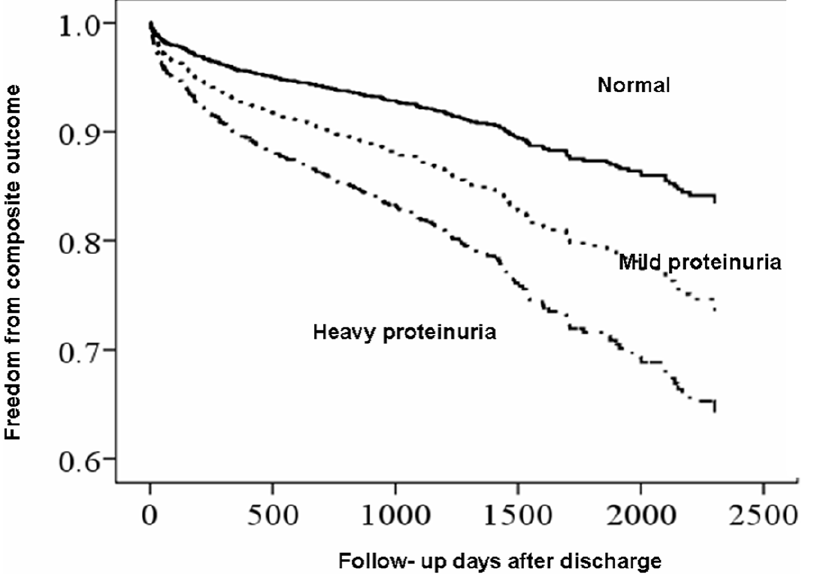
Figure 3. Proportion of freedom from long- term composite outcome after hospital discharge, composite outcome of ESRD and mortality, stratified by different severities of proteinuria defined by preoperative dipstick. (Mild proteinuria, p , 0.001; Heavy proteinuria, p , 0.001; No proteinuria was the reference calculated by multivariable Cox proportional hazard analyses).